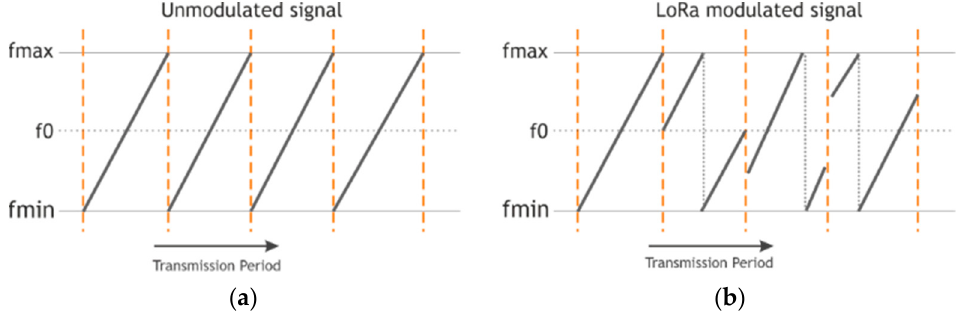
Figure 1. Signal modulation: ( a ) unmodulated signal; ( b ) LoRa-modulated signal.